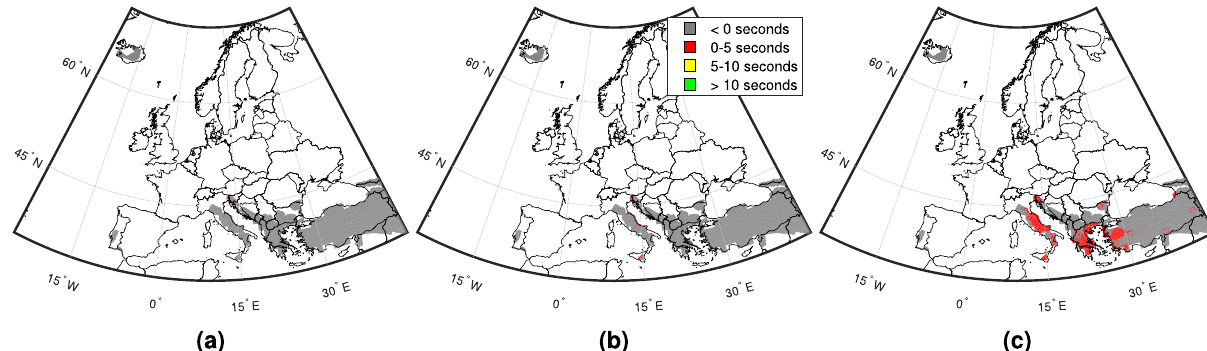
Fig. 6 Lead-time mapping for a 0.1 g EEW alert threshold. a Minimum lead times, b median lead times, and c maximum lead